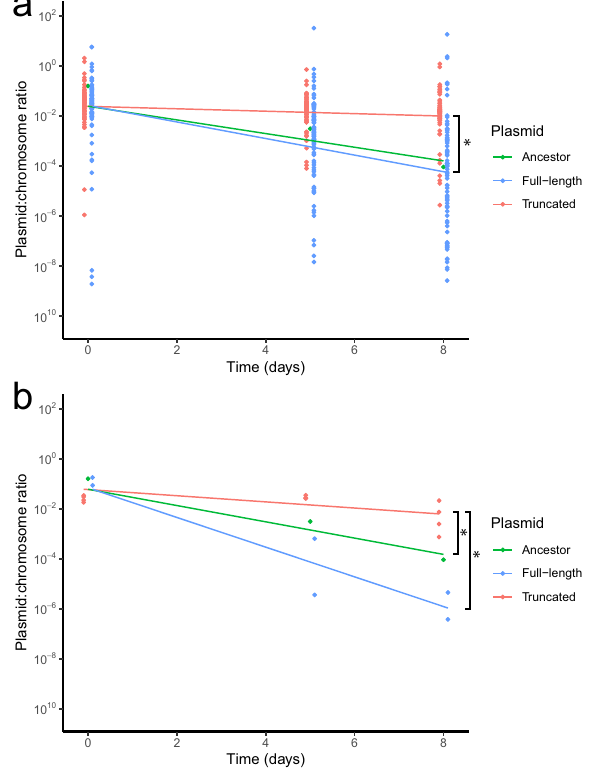
Fig. 4 Persistence of plasmids. Persistence of plasmids evolved in Tet + bio fi lms and planktonic populations tested in a their co- evolved hosts (92 full-length and 49 truncated plasmids), and b in the ancestral host (two full-length and four truncated plasmids). In both panels, the ancestral plasmid was tested in the ancestral host. Plasmid persistence is shown as the estimated ratio of trfA /16S rRNA genes over time. Lines are the results of the log-linear model for each group. *Denotes a signi fi cant difference ( t -test p -value was < 0.05) between the groups indicated by the brackets: truncated plasmids versus ancestral plasmids and full-length plasmids.